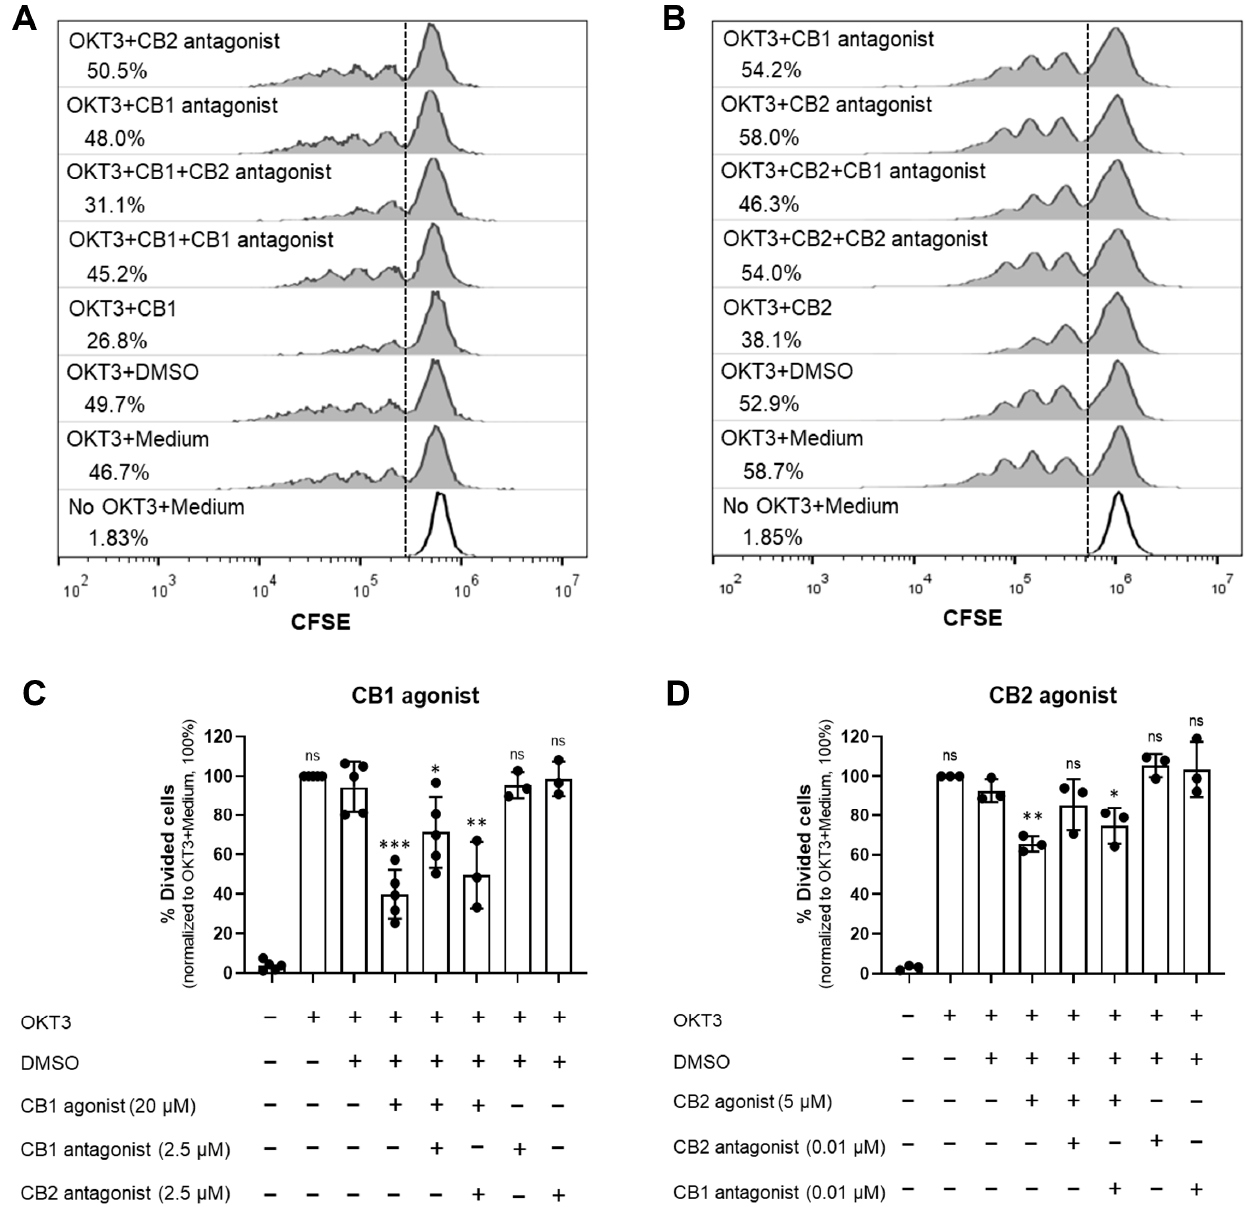
6 of 17 Figure 1. CB1 and CB2 agonists inhibit T cell proliferation . CFSE labeled PBMCs were activated with anti - CD3 mAb ( OKT3 ) or kept unstimulated ( No OKT3 ) in the presence of various concentrations of CB1 ( ACEA ) or CB2 ( GW833972A ) agonists or DMSO control ( DMSO ) for 5 days . The representa-